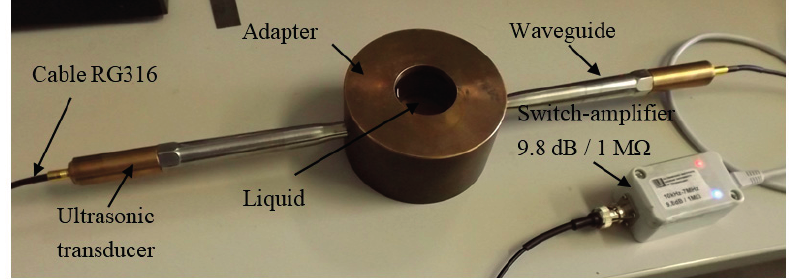
Figure 12. The calibration